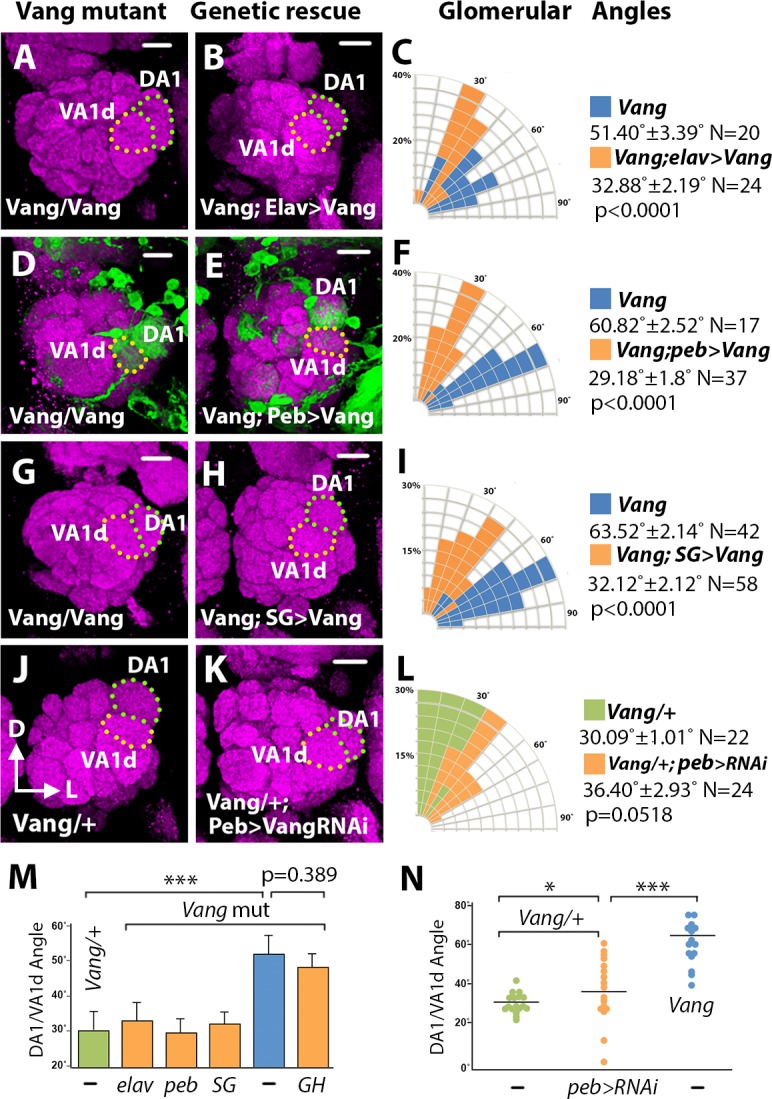
Vang functions in the ORNs to regulate glomerular migration.Adult Vang6 ALs expressing Mz19-mCD8::GFP and different Vang transgenes were stained with antibodies against Brp (Magenta) and CD8 (green) to visualize the glomerular pattern. (A, B) Expression of UAS-Vang under the control of the pan-neuronal driver Elav-Gal4 in the Vang6 mutant (A) caused DA1 to migrate dorsally relative to the VA1d glomerulus (B). (C) Quantification of the DA1/VA1d glomerular angles in A and B. (D, E, G, H) Expression of UAS-Vang under the control of the ORN-specific drivers, peb-Gal4 (D, E) and SG18.1-Gal4 (G, H), also rescued DA1 dorsal migration. (F, I) Quantification of the DA1VA1d glomerular angles in D, E, G, and H. (J, K) Expression of UAS-VangRNAi under the control of the peb-Gal4 in the Vang6/+ mutant (J) slightly disrupted DA1 dorsal migration (K). (L) Quantification of the DA1VA1d glomerular angles in J and K. (M) Graph summarizing the glomerular angles in the rescue experiments. ANOVAs were used to simultaneously compare the Vang6 control and the rescued conditions. (N) Graph summarizing the glomerular angles in the VangRNAi knockdown experiment. With the exception of M, Student’s t tests were used to compare the data of the mutants with those of their respective controls. Scale bars: 10 μm.